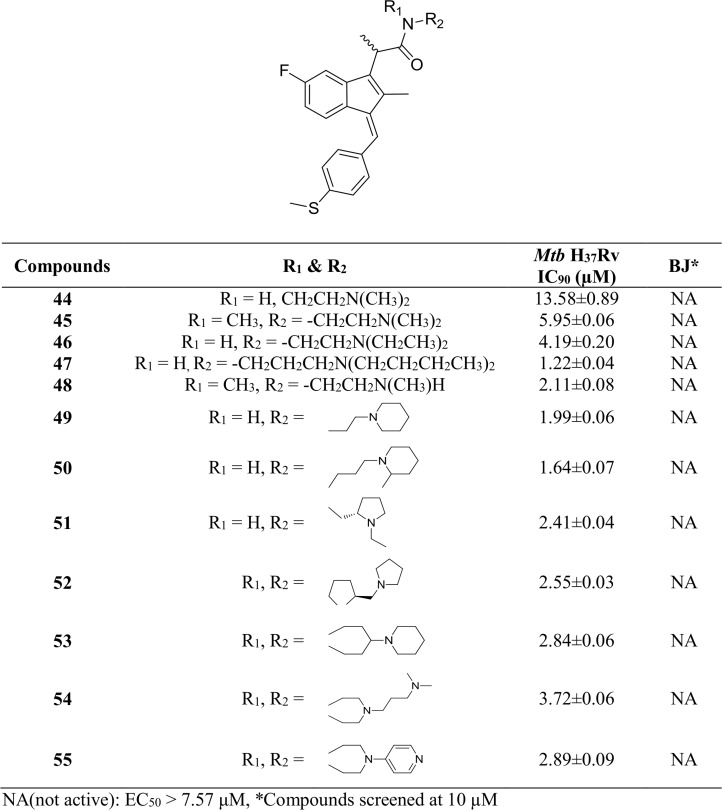
Mtb H37Rv and BJ cell data of α-methyl Sulindac sulfide amide derivatives 44–55.